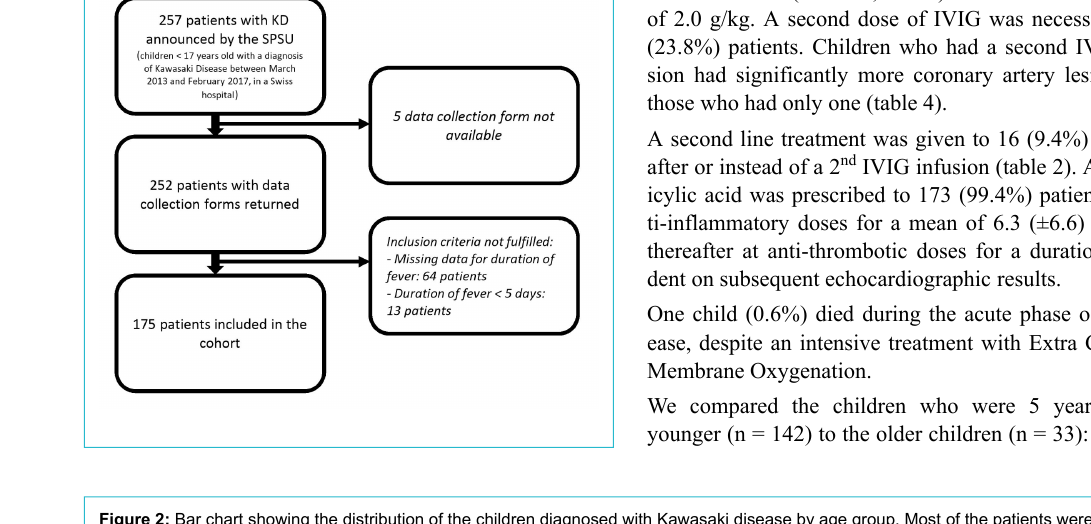
Figure 2: Bar chart showing the distribution of the children diagnosed with Kawasaki disease by age group. Most of the patients were between 0 and 4 years